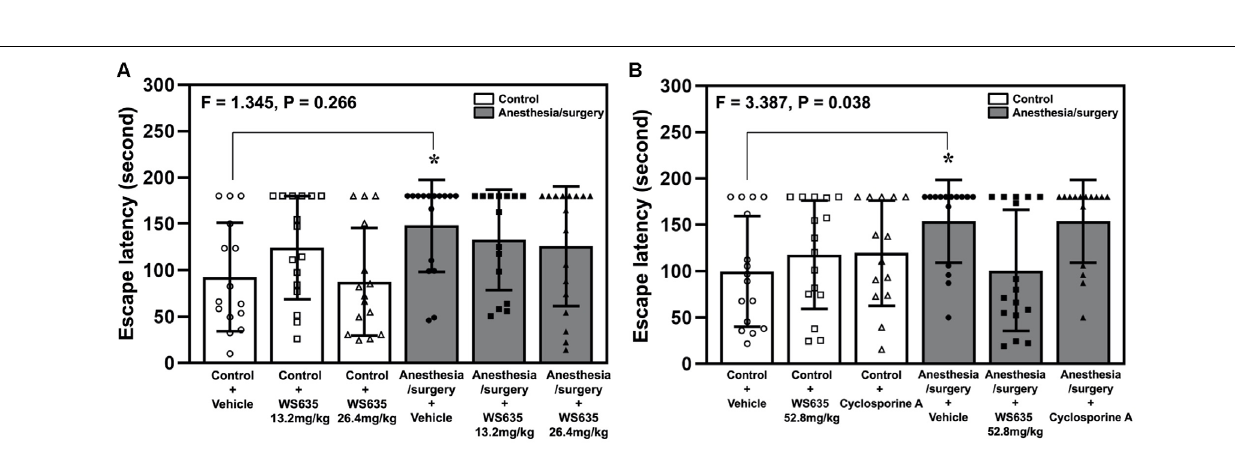
FIGURE 4 | Effects of WS635, CsA, and the anesthesia/surgery on cognitive function in mice detected in Barnes maze. (A) The effects of WS635 with 13.2 mg/kg and 26.4 mg/kg on the anesthesia/surgery-induced changes in Barnes maze’s escape latency at testing day (11 days after the anesthesia/surgery) in mice. (B) The effects of WS635 with 52.8 mg/kg and CsA on the anesthesia/surgery-induced changes in Barnes maze’s escape latency at testing day (11 days after the anesthesia/surgery) in mice. N = 14–17 mice in each group. Two-way ANOVA with the post hoc Bonferroni correction was used. * P < 0.05. P values refer to the difference among different conditions on the escape latency. CsA, cyclosporine